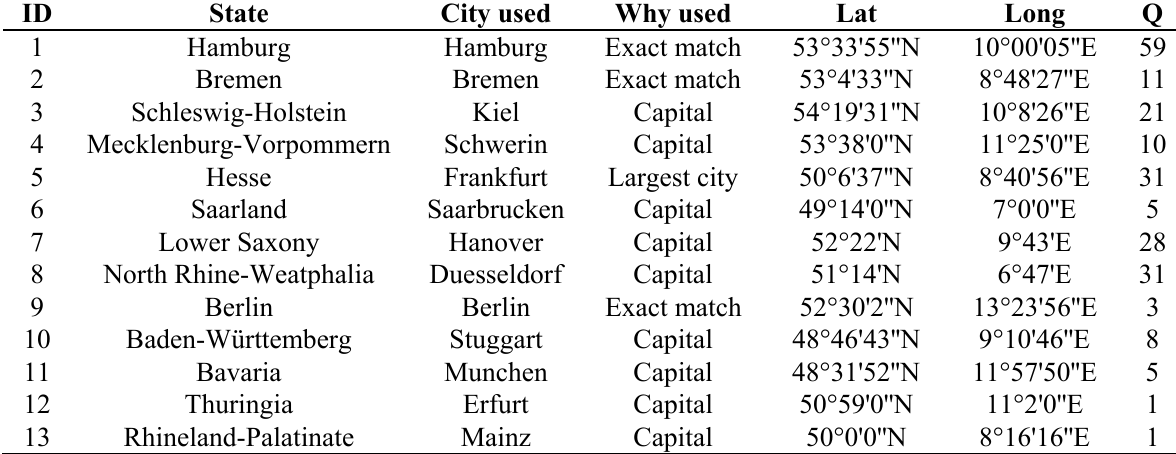
Table 8. Geographic location of the first 13 cities/areas with at least one case of HUS.